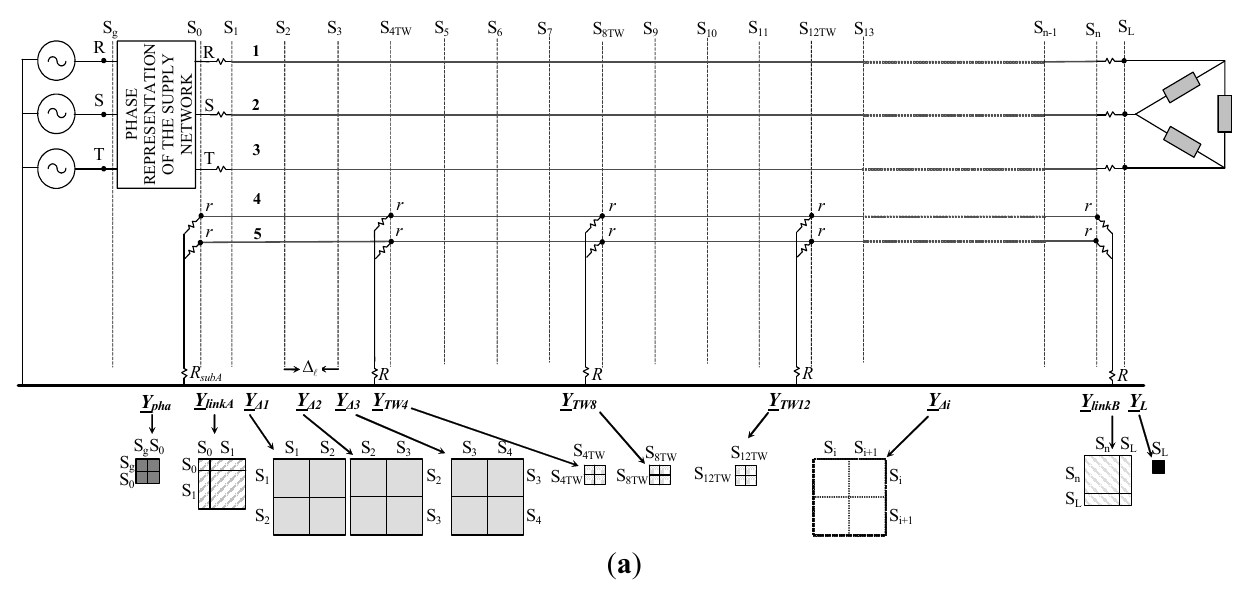
Figure 3. ( a ) Single circuit overhead line; ( b ) Structure of the matrix Y